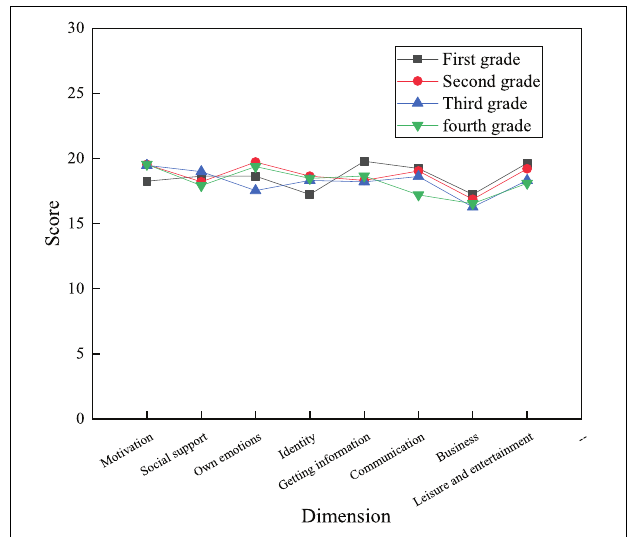
FIGURE 9 | Influences of majors on the use of network buzzwords by college students.